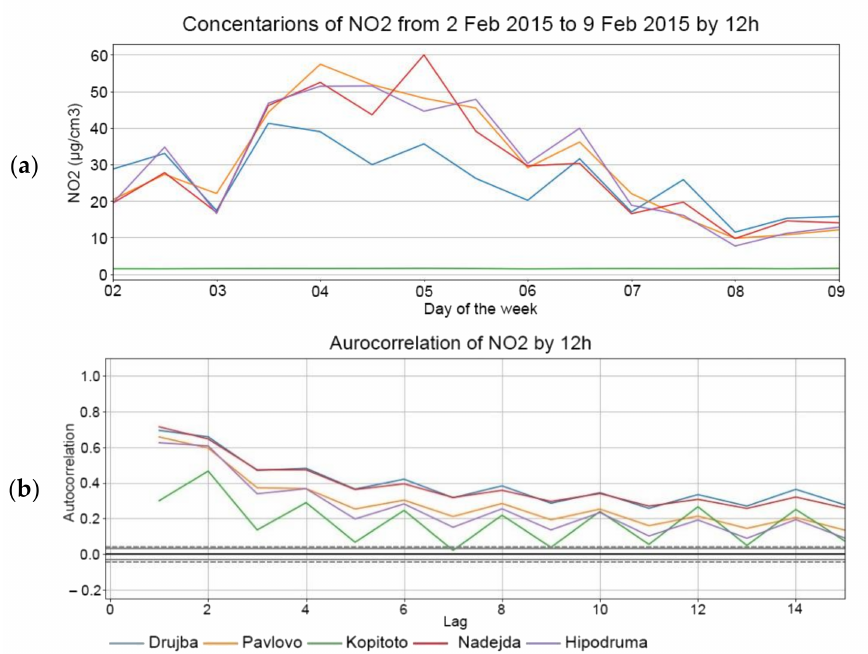
Figure 7. The signal for the different stations corresponding to NO 2 measured by 12 h ( a ) and the corresponding autocorrelation ( b ).